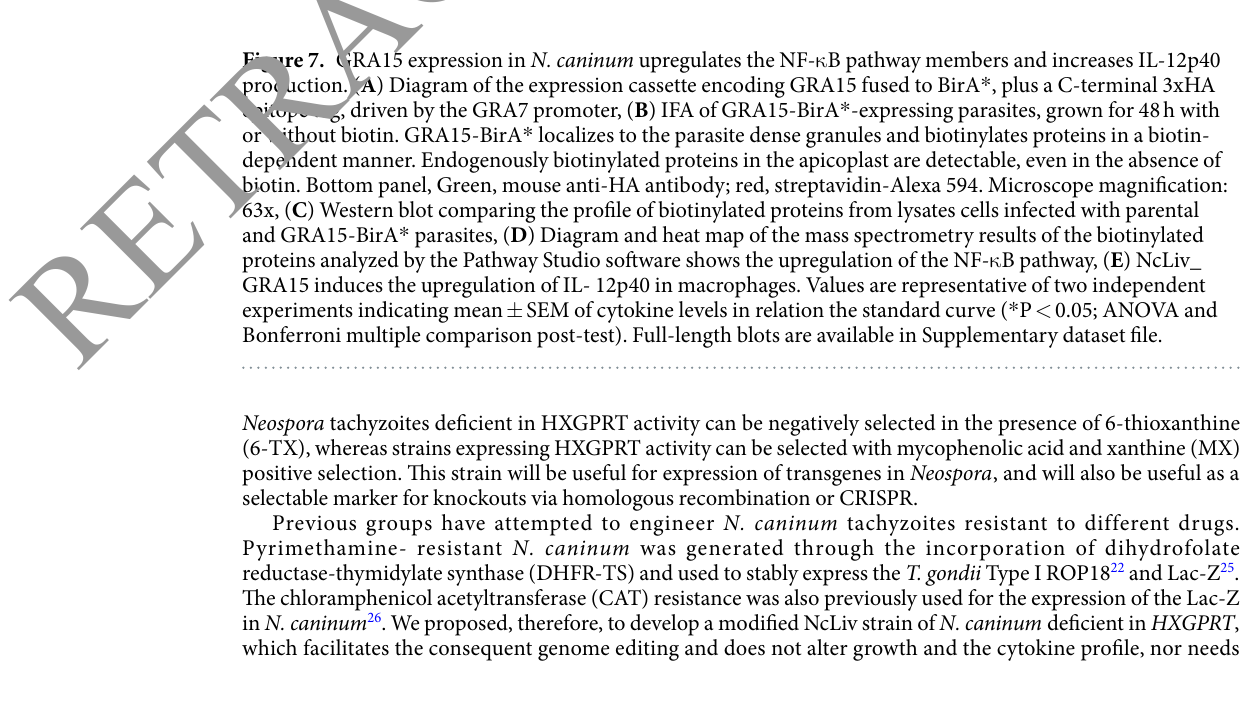
7 Scientific RepoRts | 7: 3768 | DOI:10.1038/s41598-017-03978-1